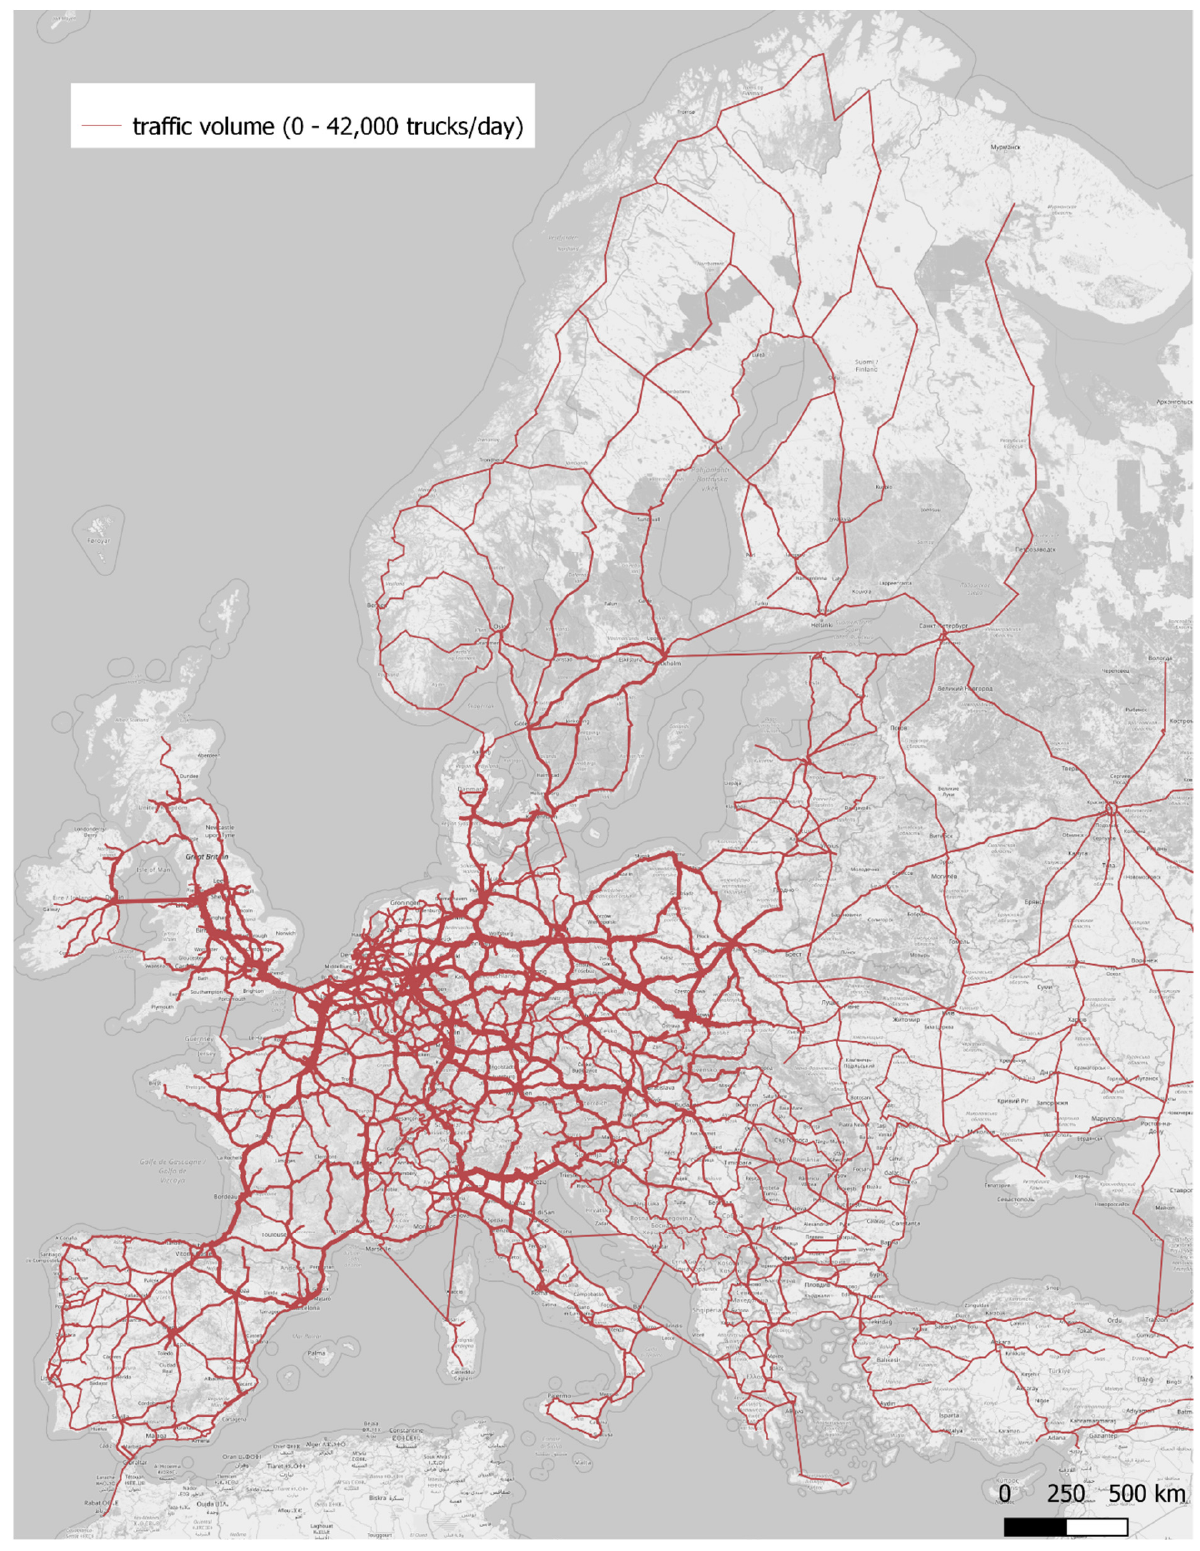
Figure 1. Traffic volume in Europe 2030. Own illustration based on [23]. Background: OpenStreetMap.